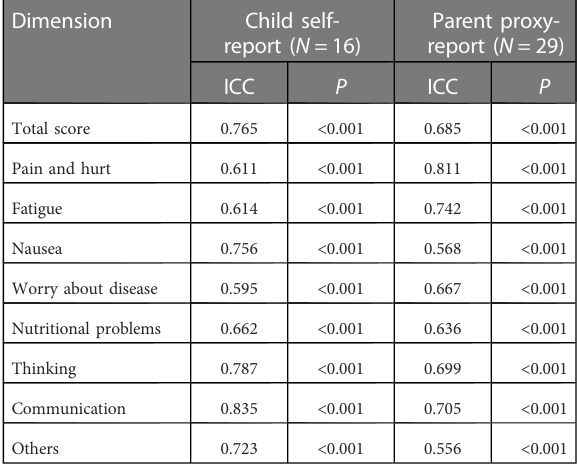
TABLE 5 Test-retest reliability of the stem cell transplant module.